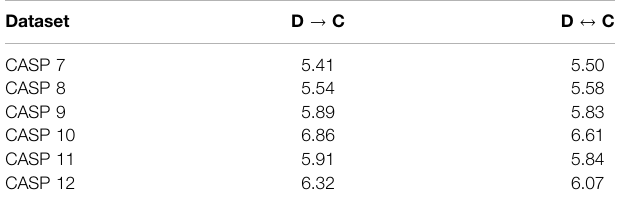
TABLE 5 | Comparison between Design to Coordinates (D → C) and reversible learning (C ↔ D) on CASP 7 – 12. Results are reported in dRMSD